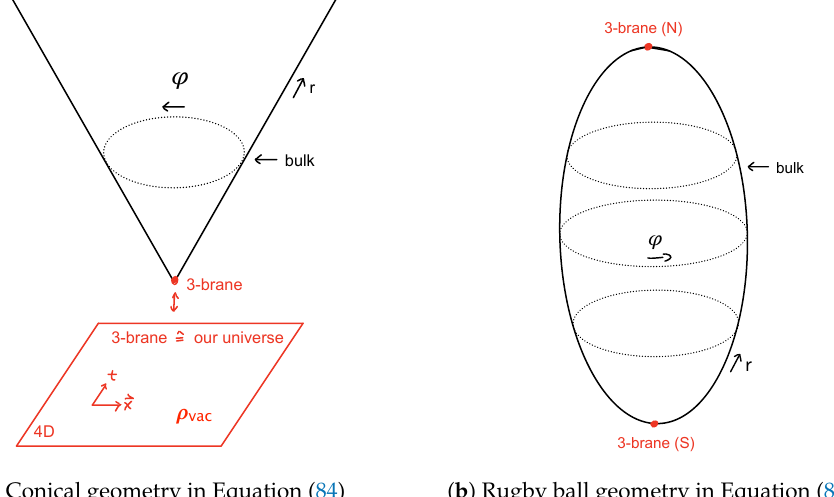
Figure 2. Geometry ( a ) and ( b ) are employed in higher-dimensional generalizations of the DGP model (infinite extra space volume) and the SLED model (finite extra space volume), respectively. The red dot corresponds to our